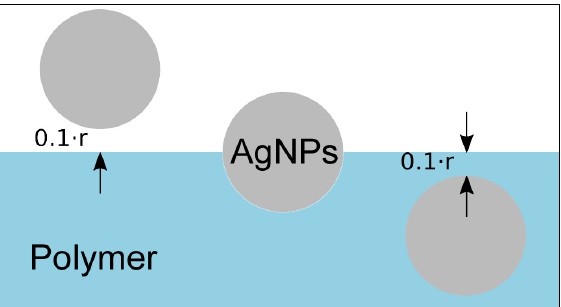
Figure 13. Geometry of three limit positions of AgNPs relative to the polymer surface (from left to right): nanoparticle in the water in the vicinity of polymer, half-submerged into polymer surface, and completely submerged.